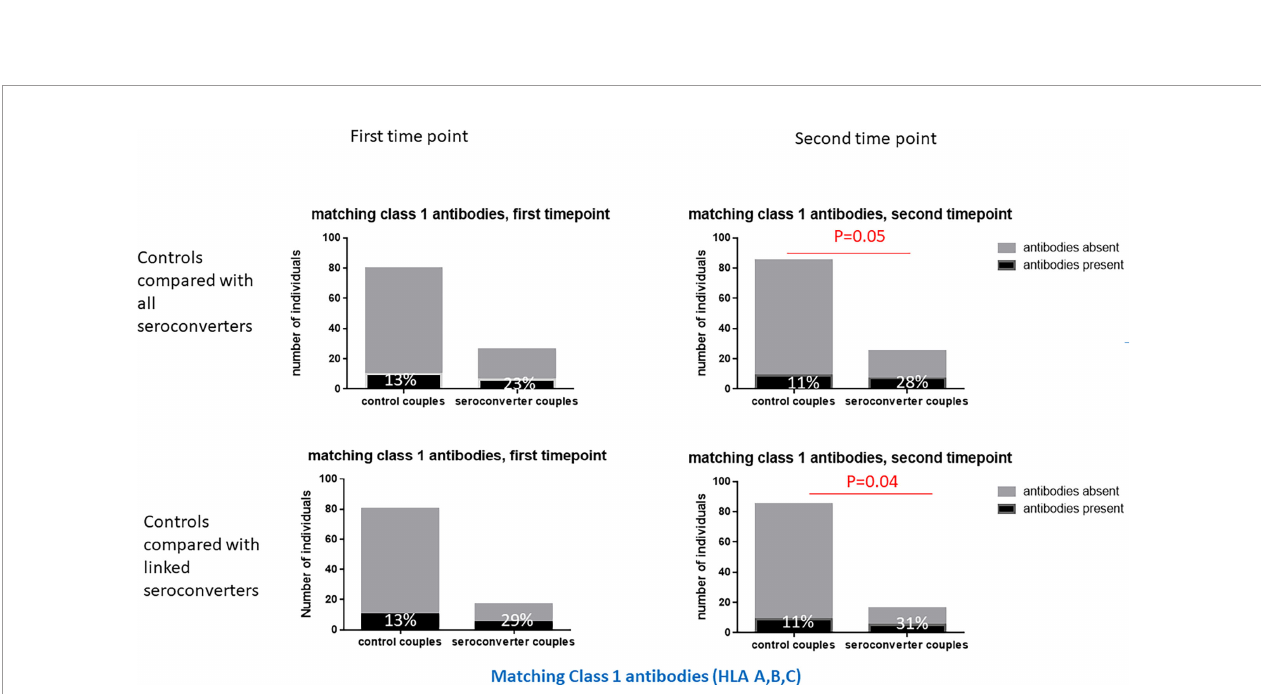
FIGURE 4 | Matching class 1 HLA antibodies in HIV-seroconverters compared with highly exposed persistently seronegative controls, at the fi rst and second timepoints. Upper panel shows comparison of highly exposed persistently seronegative controls with all seroconverter couples. Lower panel shows comparison of highly exposed persistently seronegative controls with only linked HIV-seroconverters. At the second timepoint, a signi fi cantly higher proportion of HIV- seroconverters, following HIV seroconversion, than highly exposed persistently seronegative controls expressed matching class 1 HLA